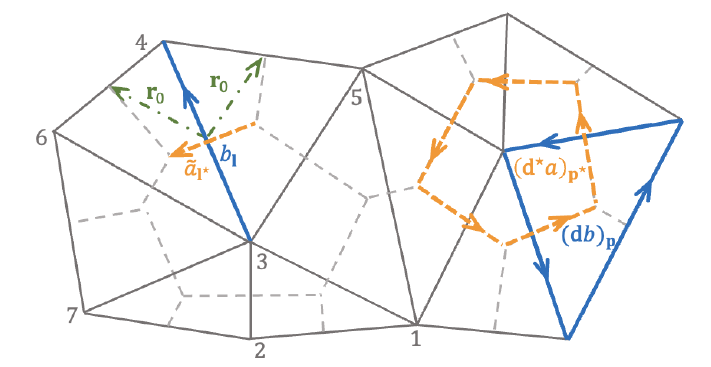
Figure 4. Illustration for the triangulated lattice (solid line) and the dual lattice (dash line), the conjugate pairs of operators, and the lattice and dual lattice “exterior derivatives”. The natural directions of the lattice links are defined to be always pointing from the vertex with a smaller index to the one with a greater index, and the natural directions of the dual lattice links are defined to be 90 -degrees counter-clockwise to the associated lattice link directions. For the example shown here, the link connecting 3 , 4 has two r pointing towards links connecting 4 , 5 and 4 , 6 0